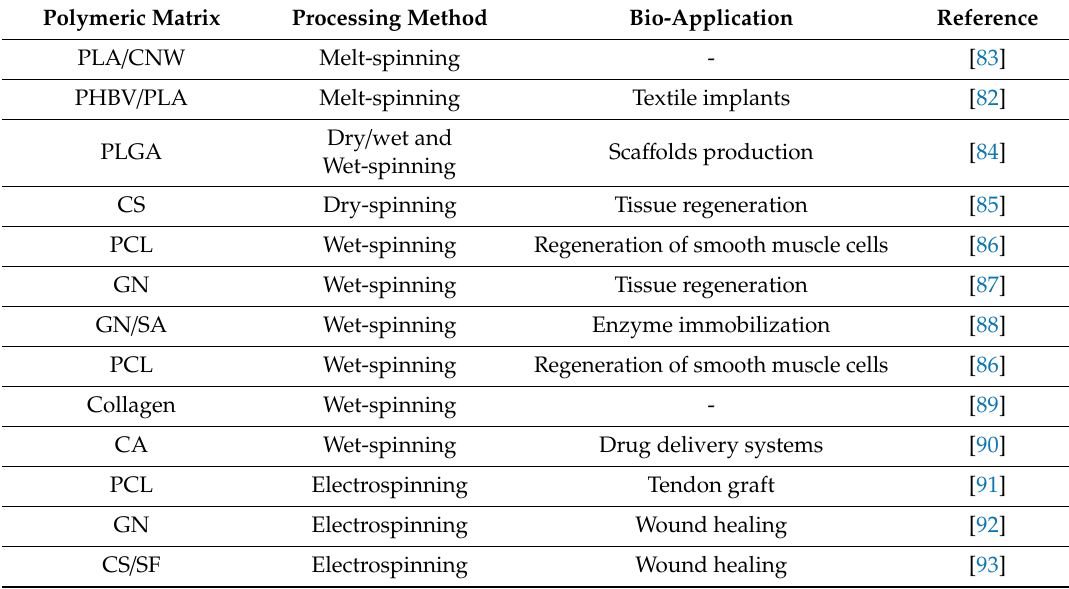
Table 2. Some of the representative spinning systems studied for biomedical applications. Polymeric Matrix Processing